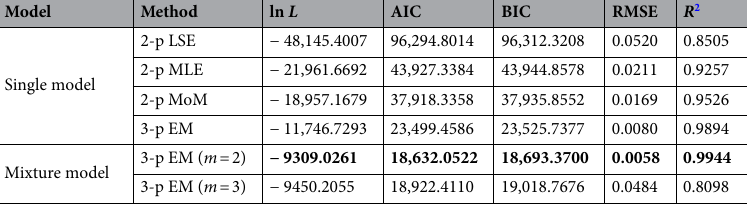
Table 3. Comparison results with different methods for Weibull wind speed model. Two-parameter and three-parameter are abbreviated as 2-p and 3-p, respectively. Based on a comprehensive technique of model selection, two-component three-parameter Weibull mixture model is selected as the optimal model for wind speed. The results of the best model are in bold